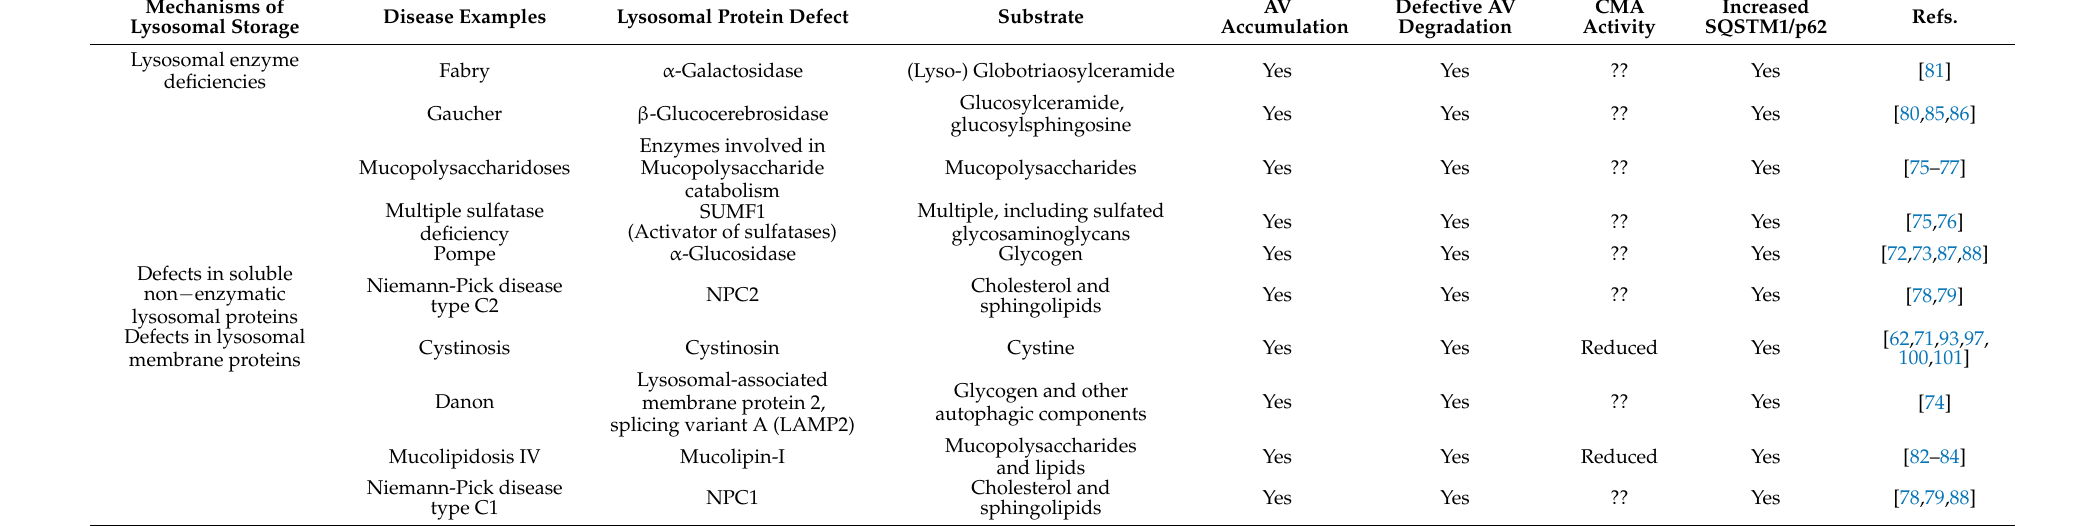
Table 1. Autophagy pathways in lysosomal storage